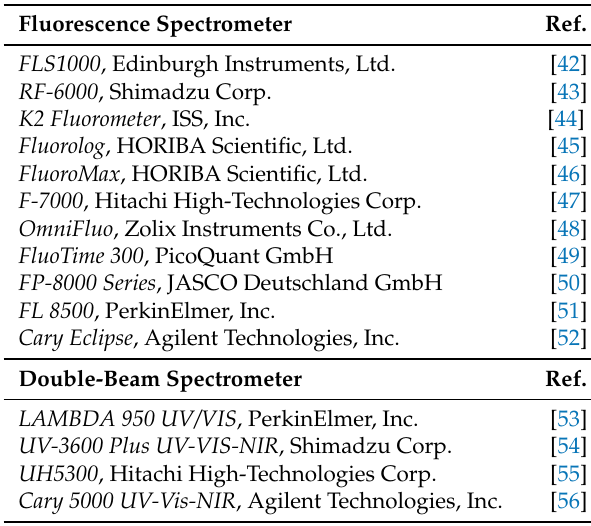
Table 1. A non-exhaustive selection of spectrometers capable of performing diffuse reflectance measurements.